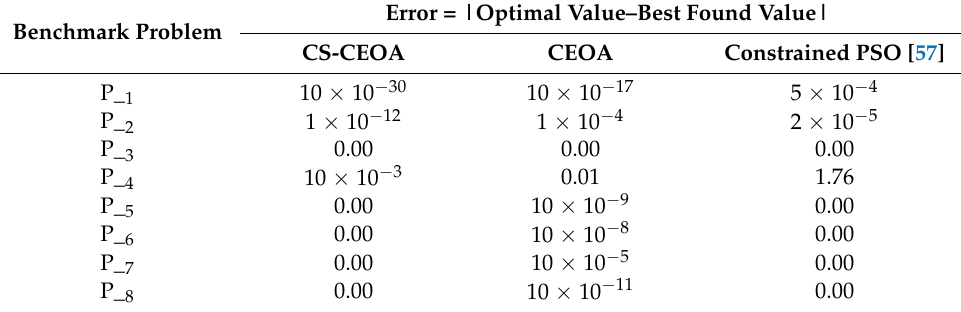
Table 4. Error provided by constrained PSO, CEOA, and